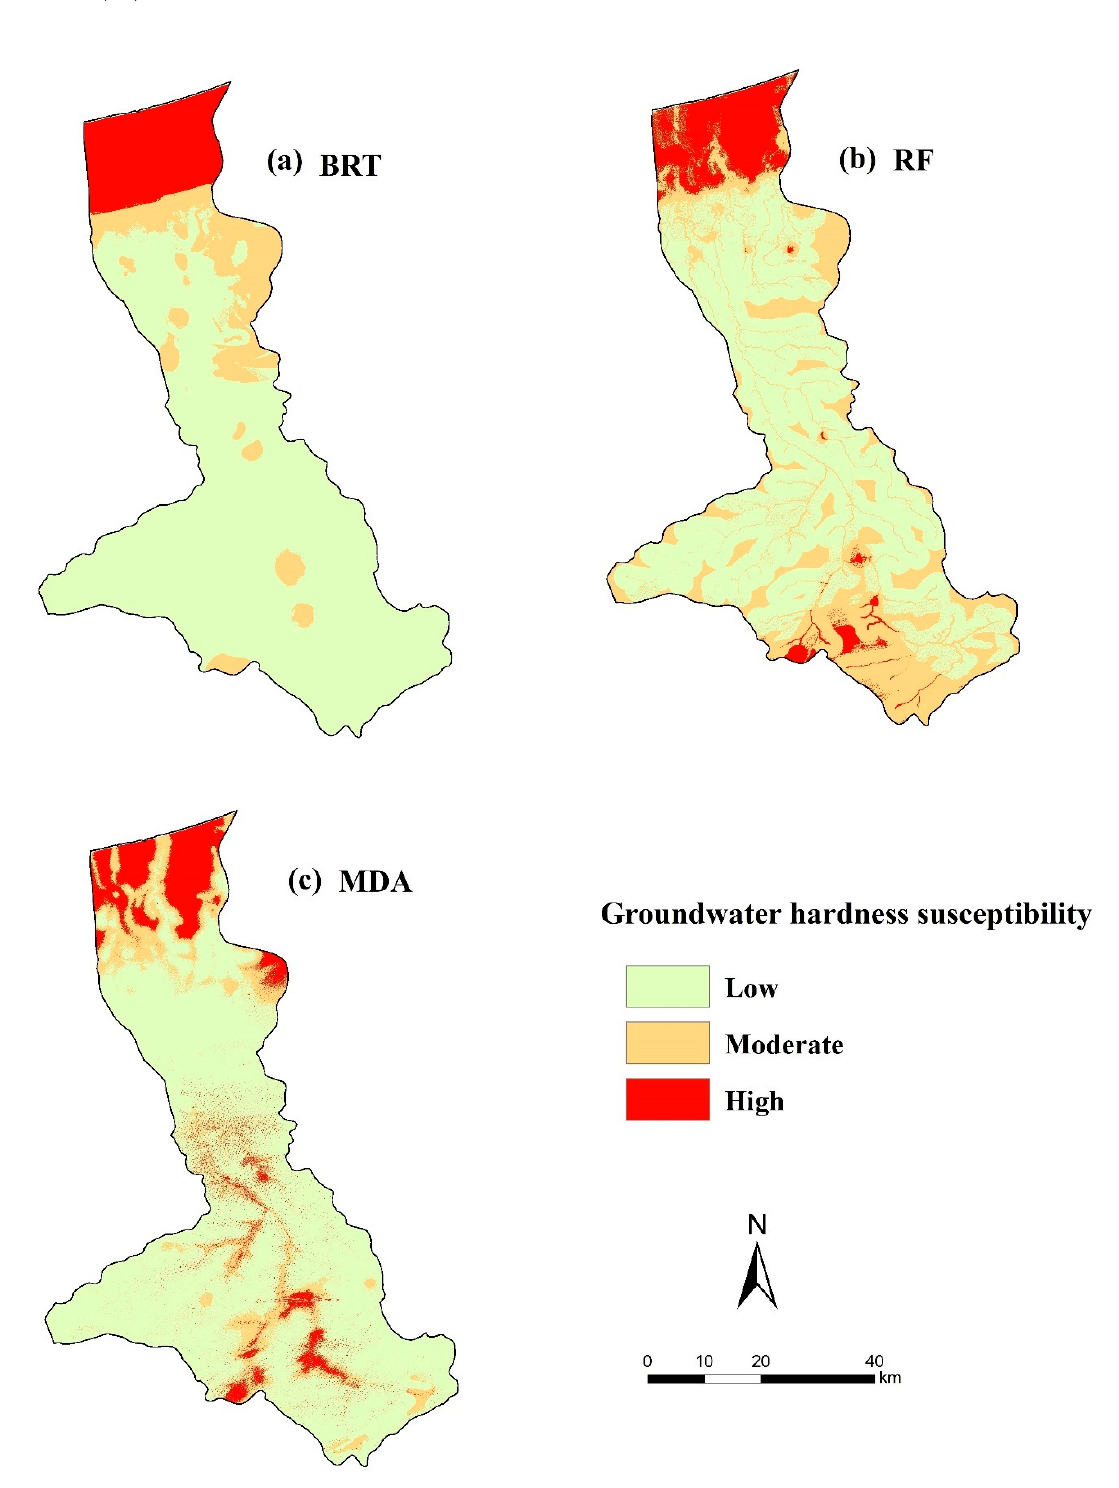
Figure 4. Groundwater hardness susceptibility maps: predicted by the BRT ( a ), RF ( b ) , and MDA ( c ) models. Table 4. Susceptibility classes area (km 2 ) in each model.